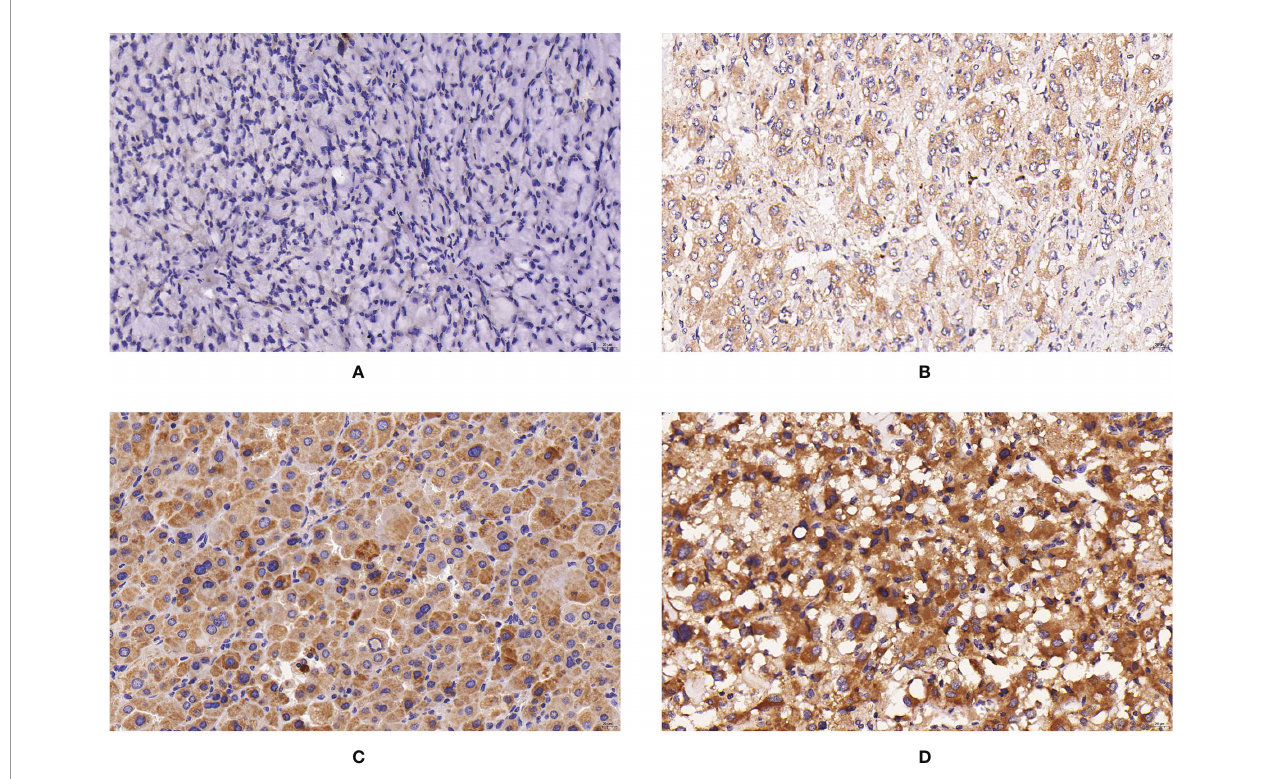
FIGURE 1 | Expression of SUCLG2 in PPGLs. (A) Negative immunostaining of SUCLG2 in PPGLs. (B) Weakly positive immunostaining of SUCLG2 in PPGLs. (C) Intermediately positive immunostaining of SUCLG2 in PPGLs. (D) Strongly positive immunostaining of SUCLG2 in